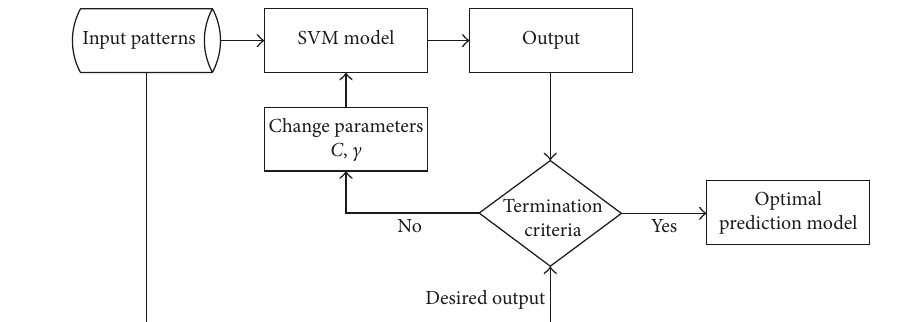
Figure 3: SVM model development.